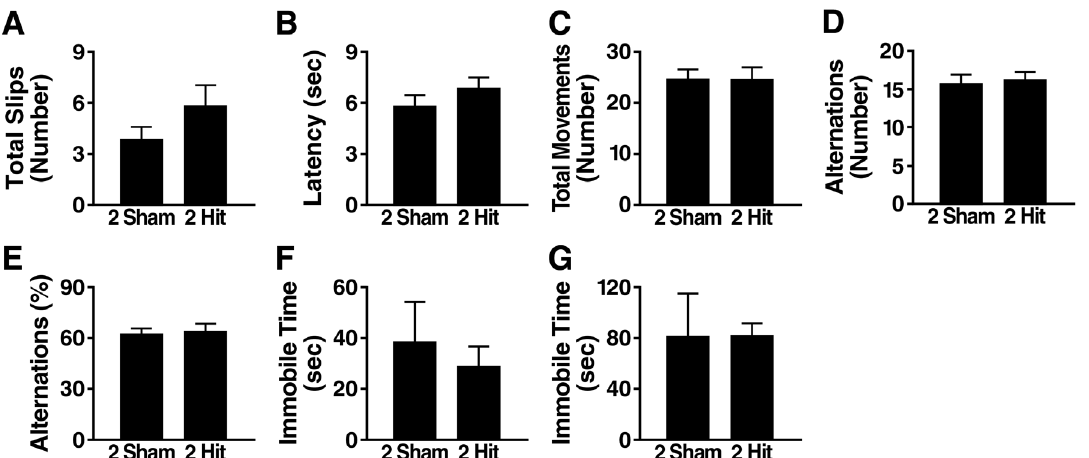
Fig. 4. Wildtype mice show no alterations in motor performance or depression-like behavior after 2-hit injury. Wildtype mice (n 5 8–10 per group) received a 2-hit frontal impact injury or sham treatment, followed by behavioral assessment. (A–B) Balance beam performance 3 weeks post-injury. (C–E) Y- maze activity 2 weeks post-injury. (F–G) Forced swim test 5 days (F) and 6 months (G) post-injury. Student’s t test revealed no significant differences between the 2-hit and sham treated groups for any of the tests and outcome measures. Data are means ¡ SEM.